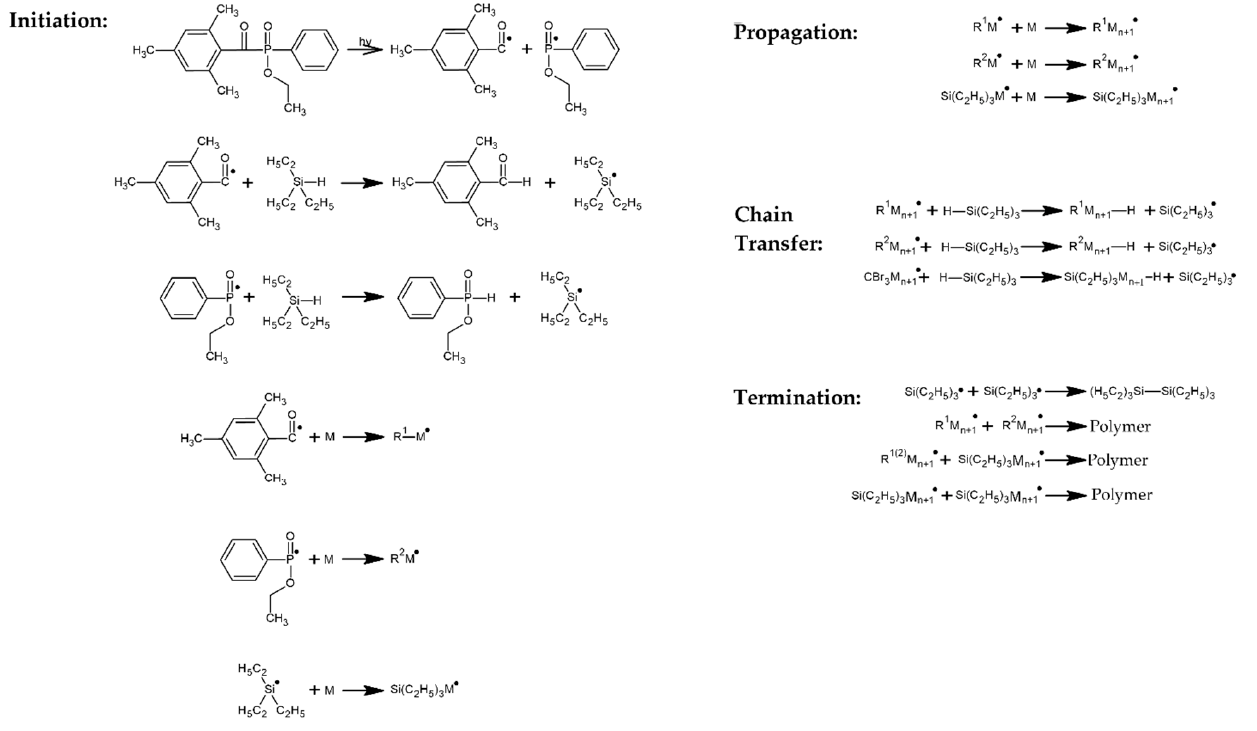
Table 1. Compositions of the monomers, photoinitiator, and telogen for the preparation of silicone-